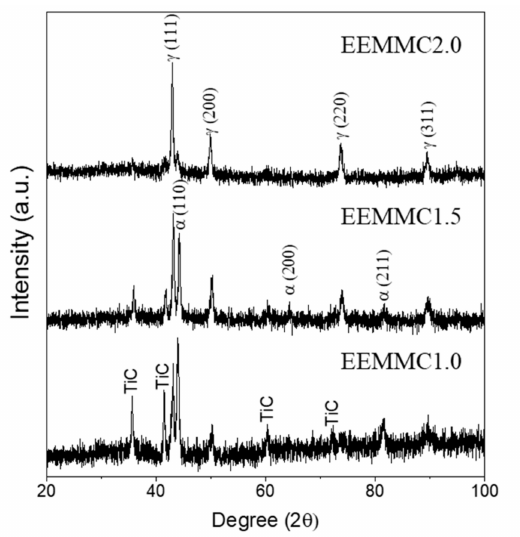
Figure 4. Phase analysis result by X-ray diffraction (XRD) results for the coating